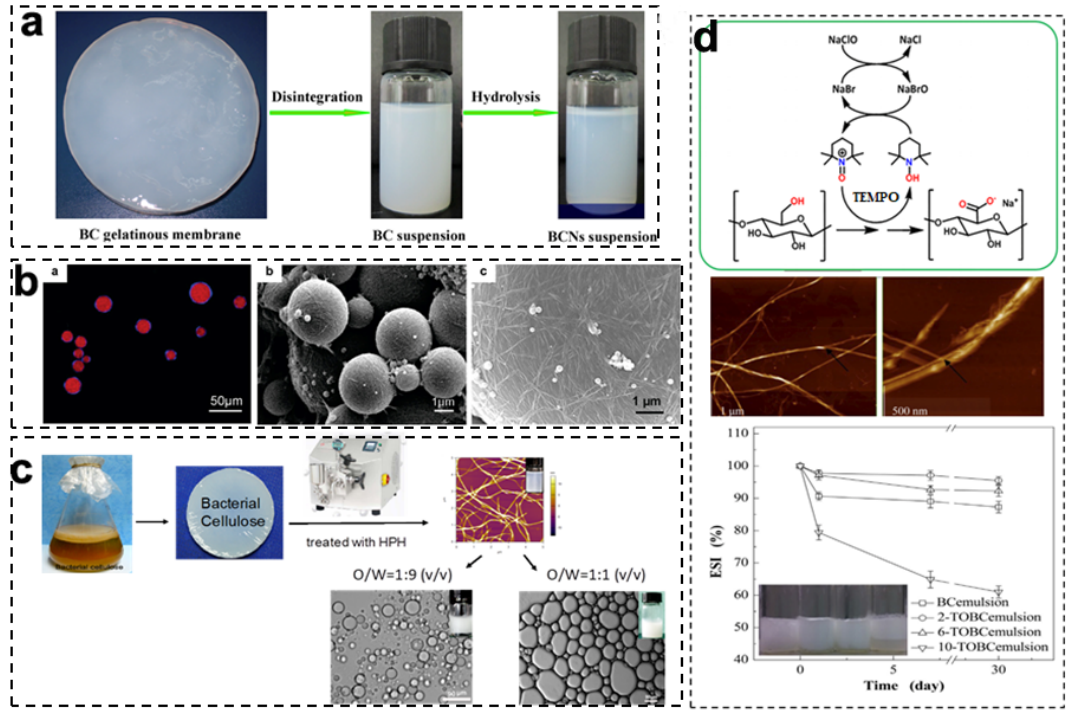
Figure 3. Studies on O/W Pickering emulsions stabilized by BC ‐ based nanoparticles: ( a ) Pictures of